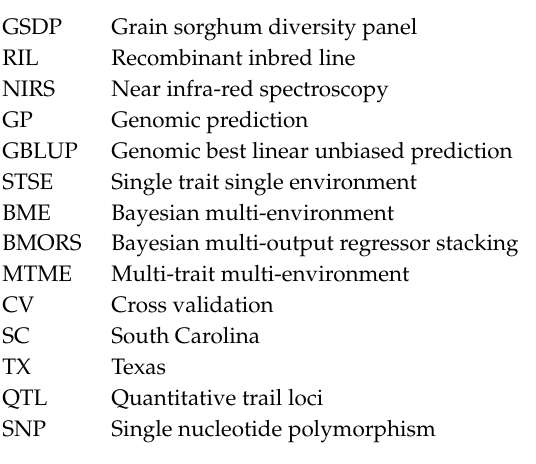
Figure S4. Overall prediction accuracy of traits across all the environment for the three prediction methods in the two populations. The y-axis shows prediction accuracy calculated as Pearson’s correlation between observed values and predicted values of phenotypes. Legend represents the environment/years. SC: South Carolina, TX: using five-fold CV in Bayesian multi-environment (BME) model. a. GSDP, and b. RILs. Legend represents the Figure S6. Heatmap for genomic relationship matrix calculated using vanRaden (2008). a. GSDP, b. RILs. Trees show hierarchical clustering using Euclidean